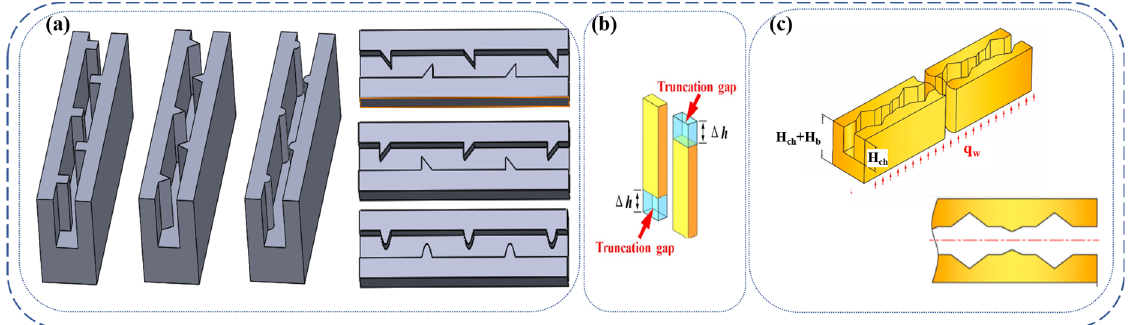
Figure 7. Wavy microchannel model [94].